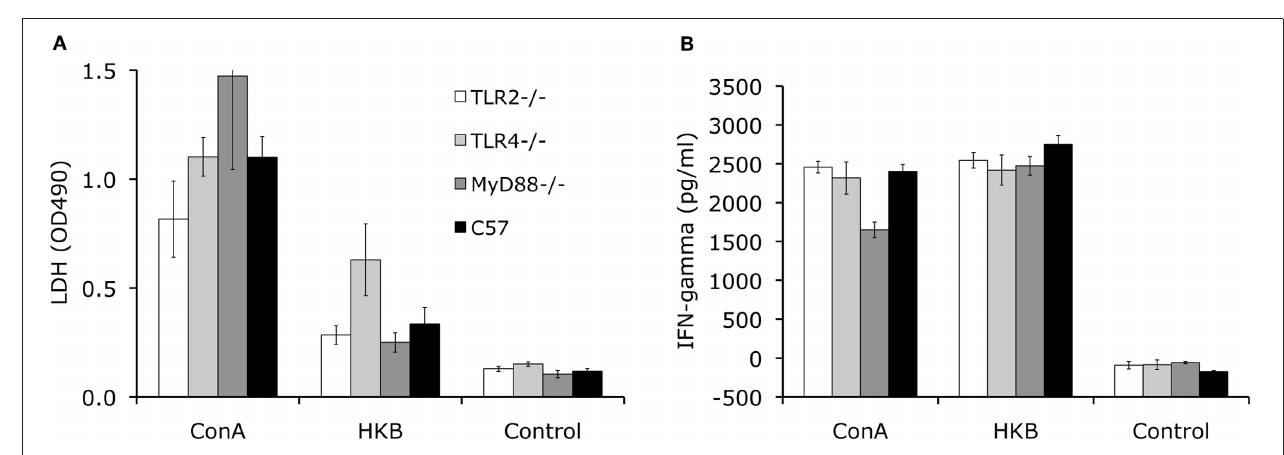
FIGURE 4 | TLR signaling is not essential for development of cellular-mediated adaptive immunity. Splenocytes collected from TLR2 − / − , TLR4 − / − , MyD88 − / − and C57BL/6 mice at 8 weeks p.i. were stimulated with heat killed Brucella (HKB) or Con A for 3 days. Lymphocyte